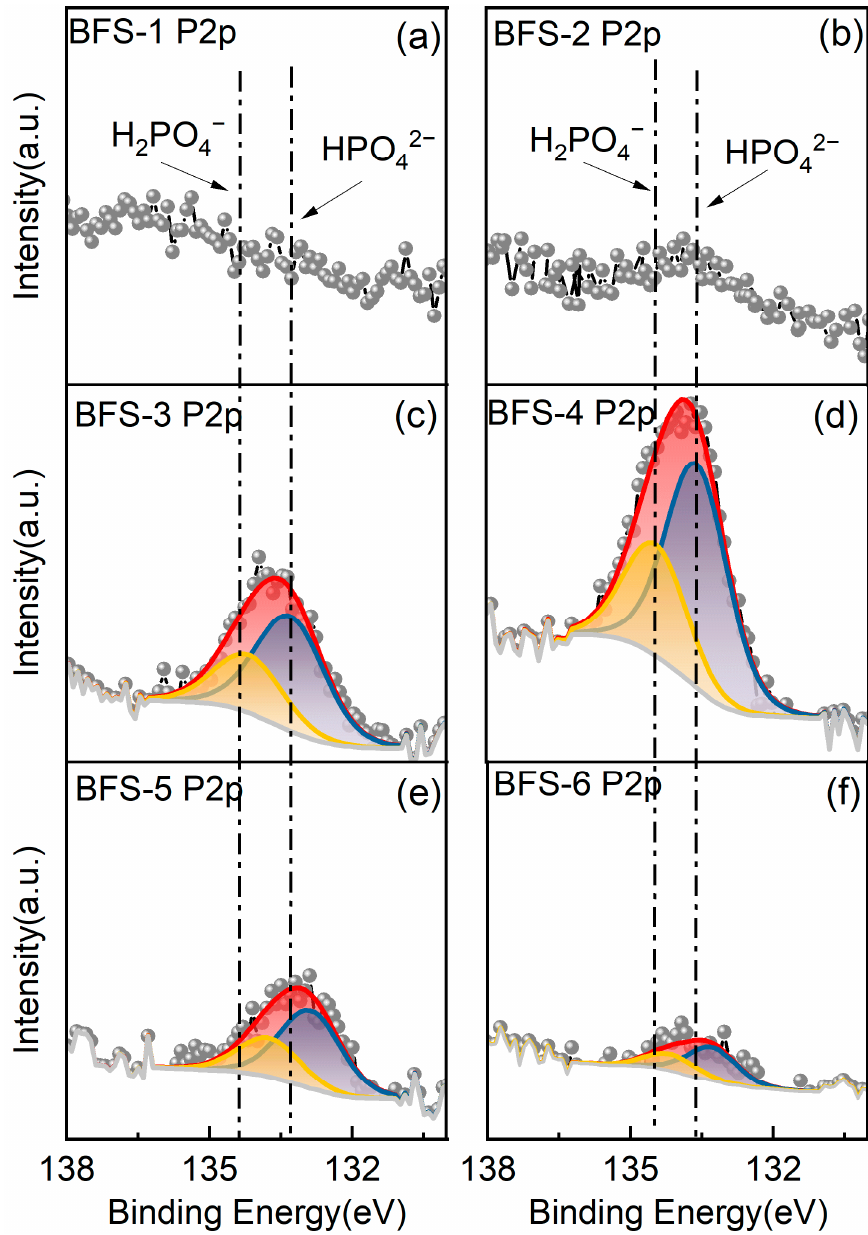
Figure 5. XPS P(2p) narrow-spectrum scan of BFS1 samples. ( a ) Magnetic BFS1 before P adsorption; ( b ) non-magnetic BFS1 before P adsorption; ( c ) magnetic BFS1 after P adsorption; ( d ) non-magnetic BFS1 after P adsorption; ( e ) magnetic BFS1 after regeneration; ( f ) non-magnetic BFS1 after regeneration.